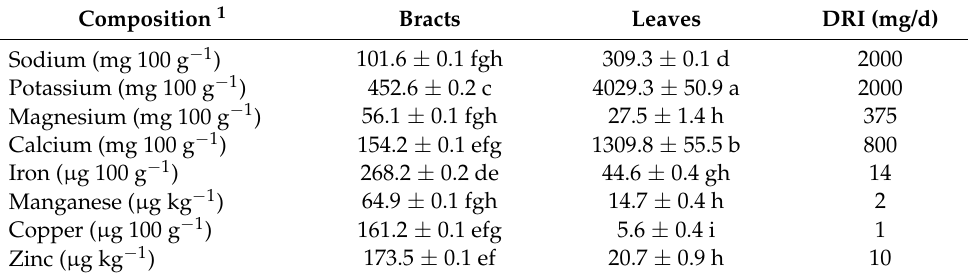
Table 7. Mineral content in the residues of bracts and leaves and daily reference intake [40]. Composition